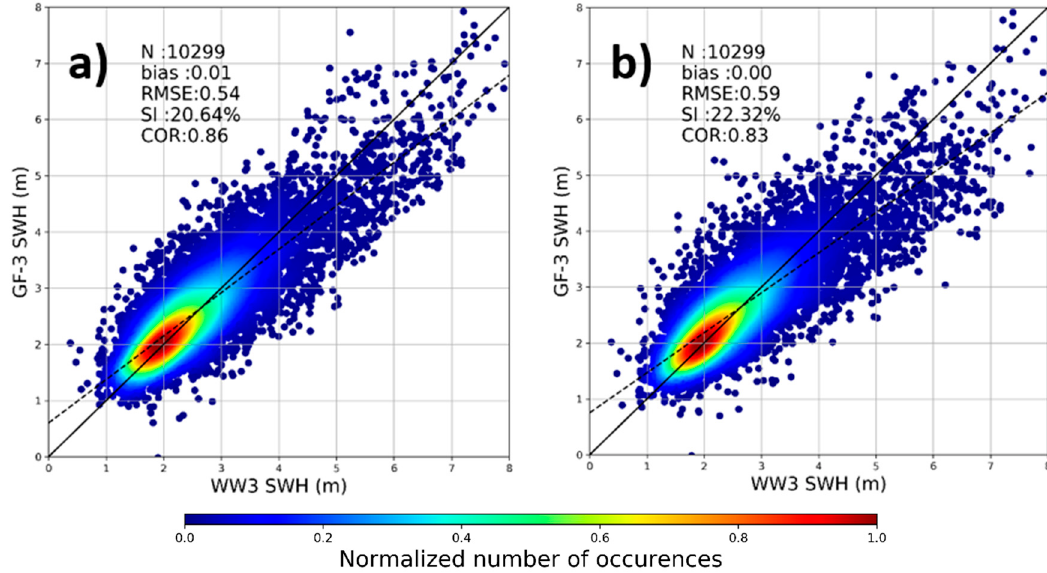
Figure 9. Scatter plots of GF-3 SWH retrievals using the empirical model of QPCWAVE_GF3 ( a ) and the empirical model excluding cross-polarized NRCS ( b ) versus WW3 SWH hindcasts.